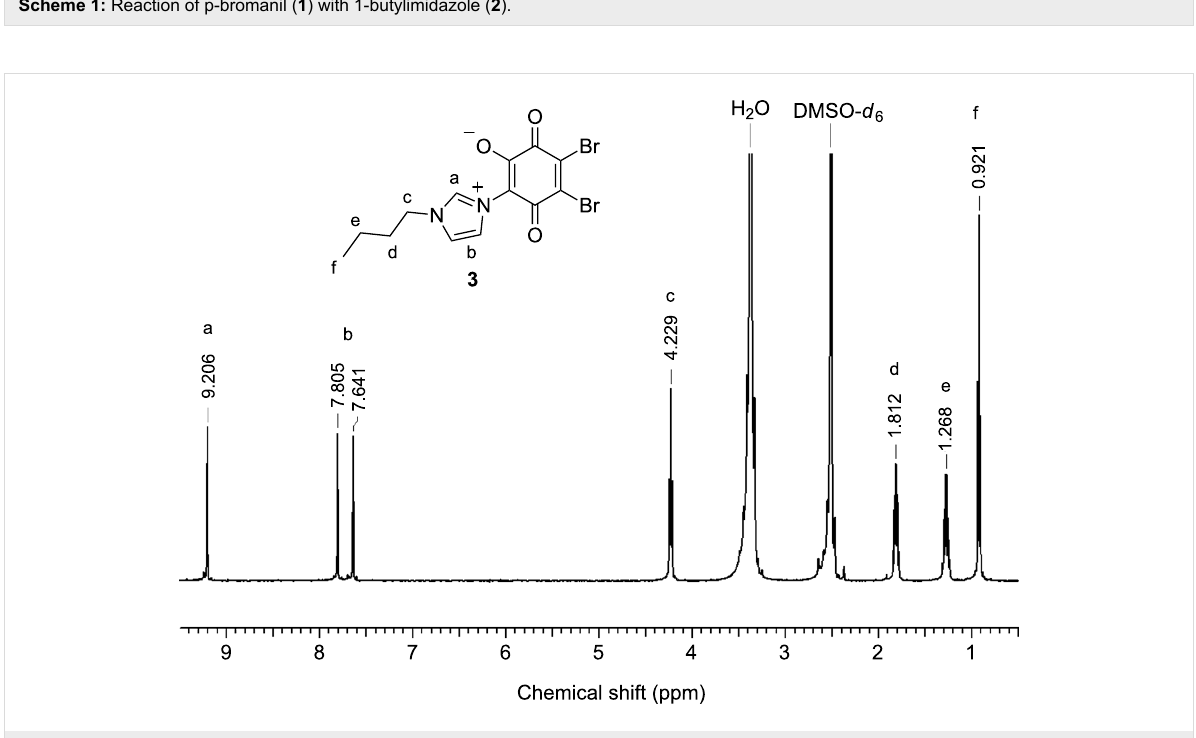
Figure 1: 1 H NMR spectrum of mesomeric betaine 3